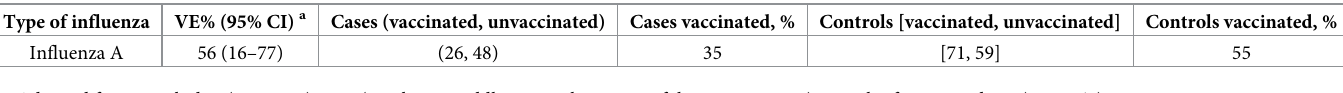
Table 4. Adjusted vaccine effectiveness (VE) of quadrivalent inactivated influenza vaccine for preventing influenza hospitalization in the 2018/19 season.